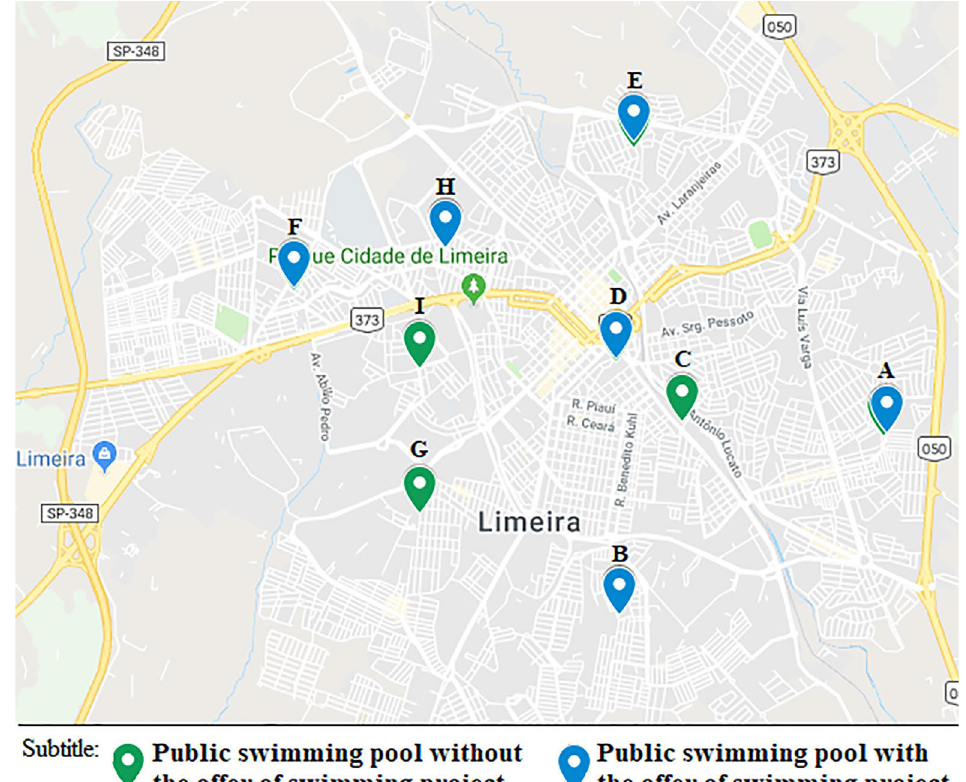
Figure 1 - Location of public swimming pools in the municipality of Limeira, SP. Source: own